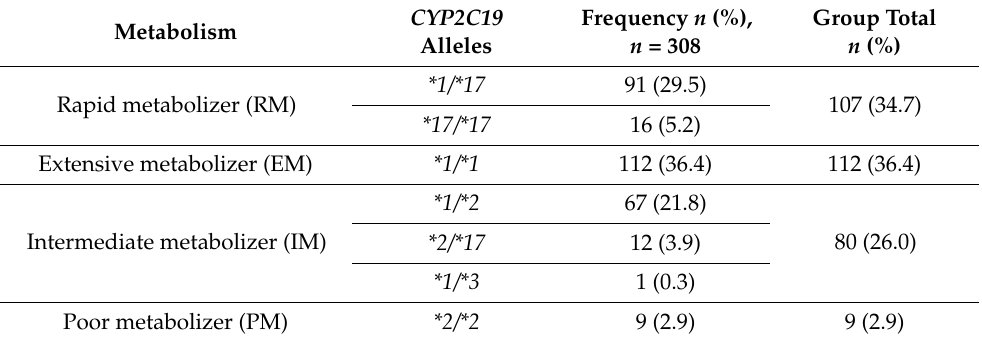
Table 2. Distribution of CYP2C19 polymorphisms in study